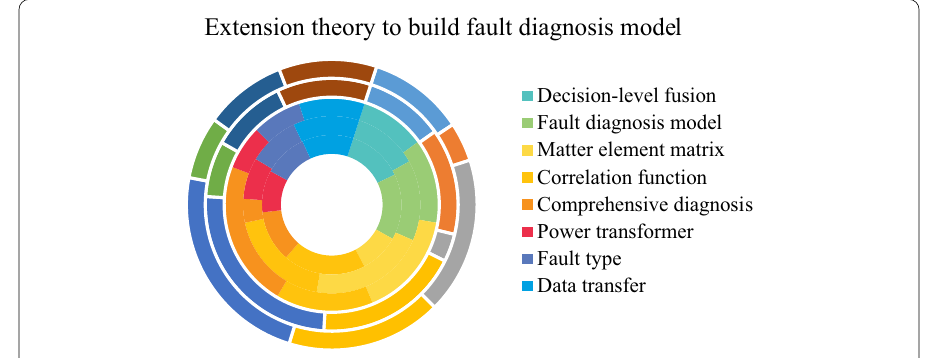
Fig. 5 Extension theory to build fault diagnosis model